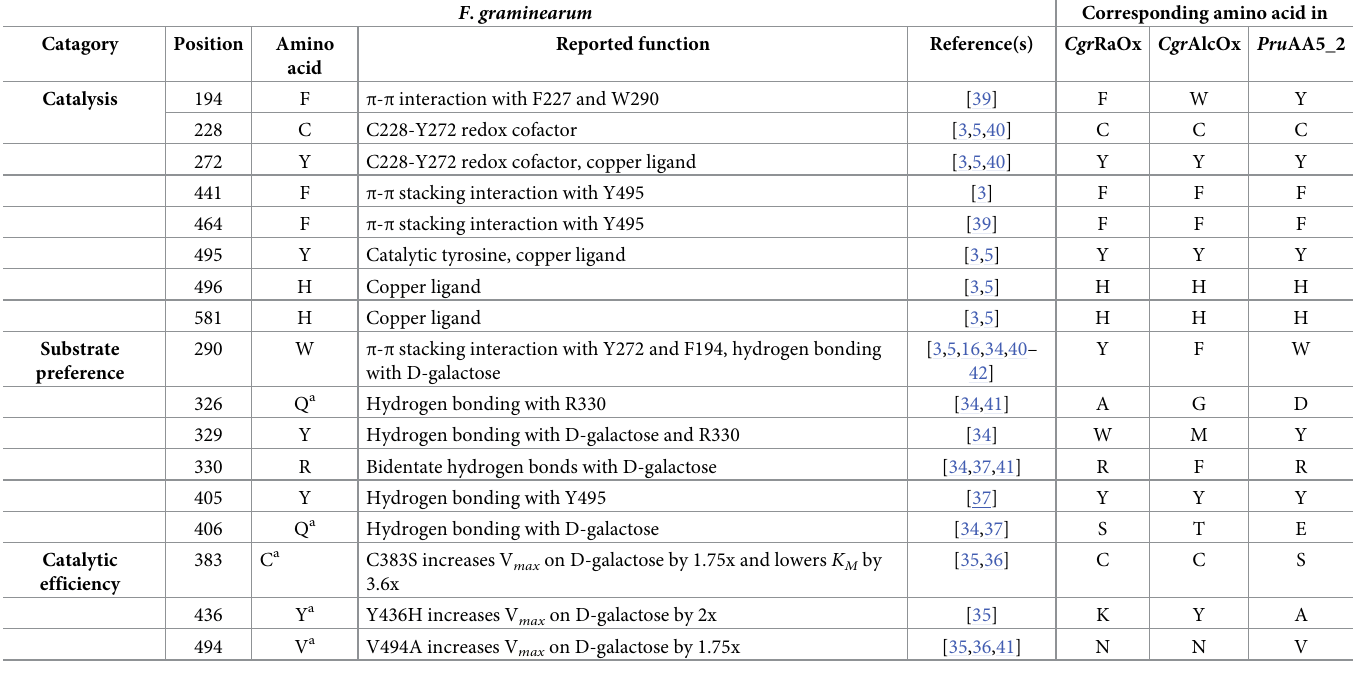
Amino acid positions correspond to the archetypal galactose oxidase from Fusarium graminearum . a Amino acids not fully conserved among AA5_2 sequences from other Fusarium species (Fig A in S1 File).